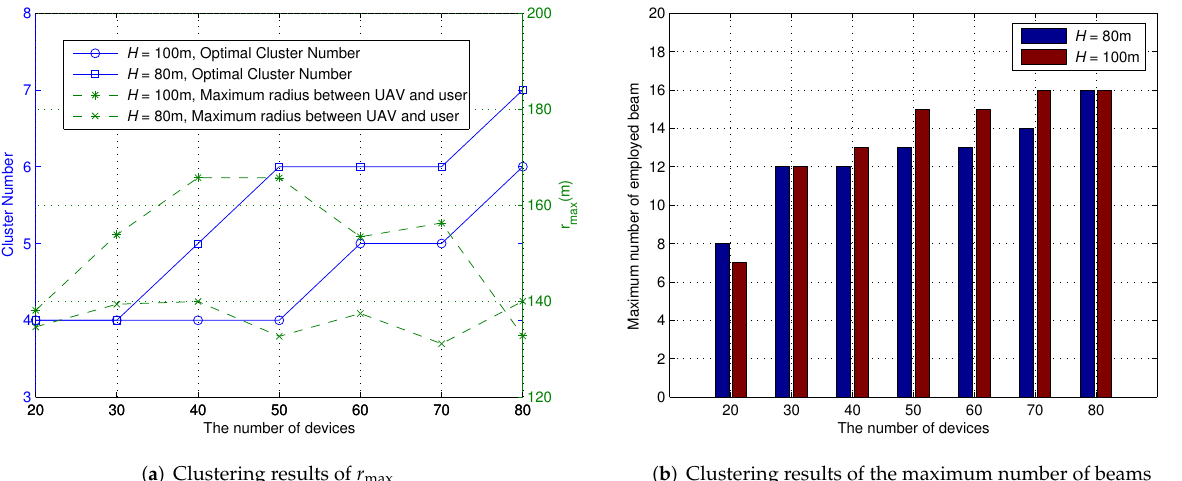
Figure 4. Optimized clustering results with different numbers of devices with a fixed UAV height of H = 80/100